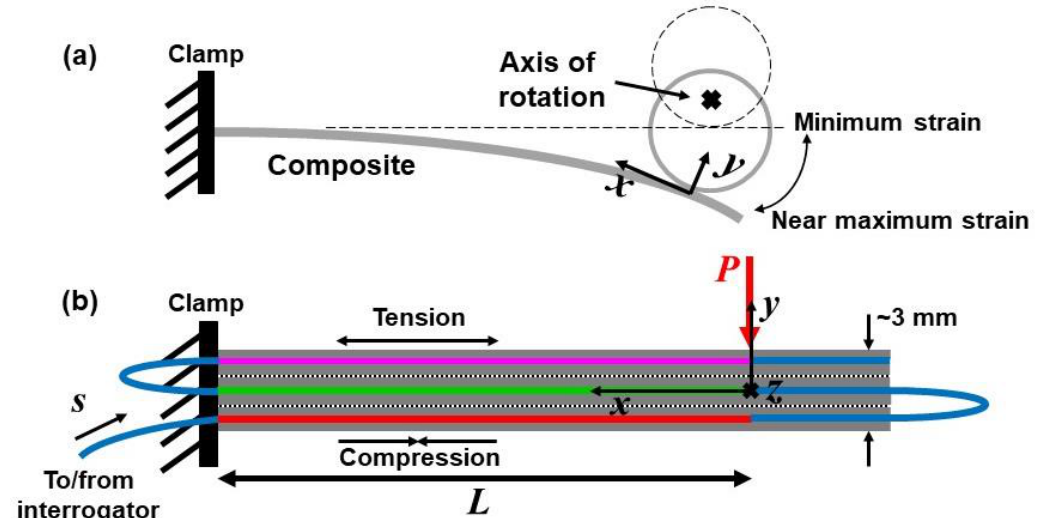
Figure 3. ( a ) Schematic of clamp, off-axis disc and composite specimen. The specimen is clamped on the left side; the disc rotates to apply varying loads to the right side on the back of the specimen. ( b ) Beam diagram showing the clamp, the applied load P and the relative location of the DOFS in the six plies of the CFRP specimen. The different segments of the DOFS where strain is measured are highlighted with different colors. The front of the specimen (red) experiences compression; the back (magenta) experiences tension. The green segment is on the neutral axis; the blue segments experience no strain.